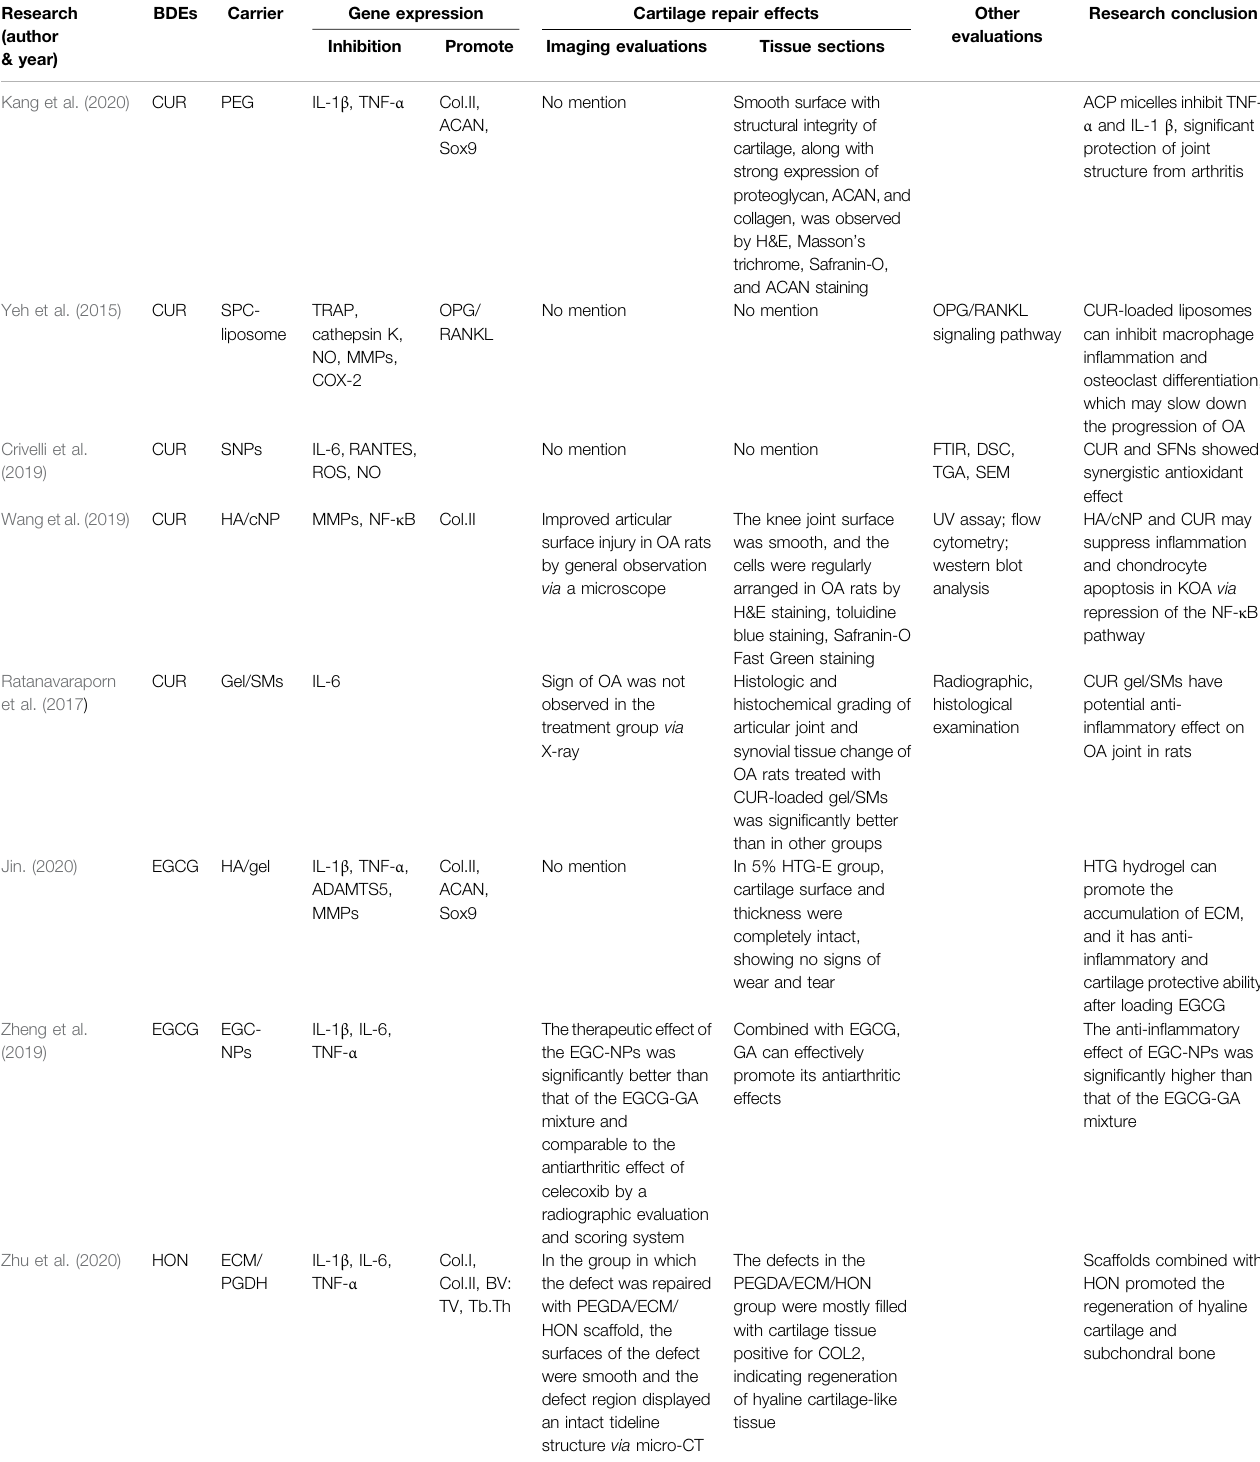
TABLE 3 | The effect of polyphenol active ingredients combined with carriers on OA cartilage